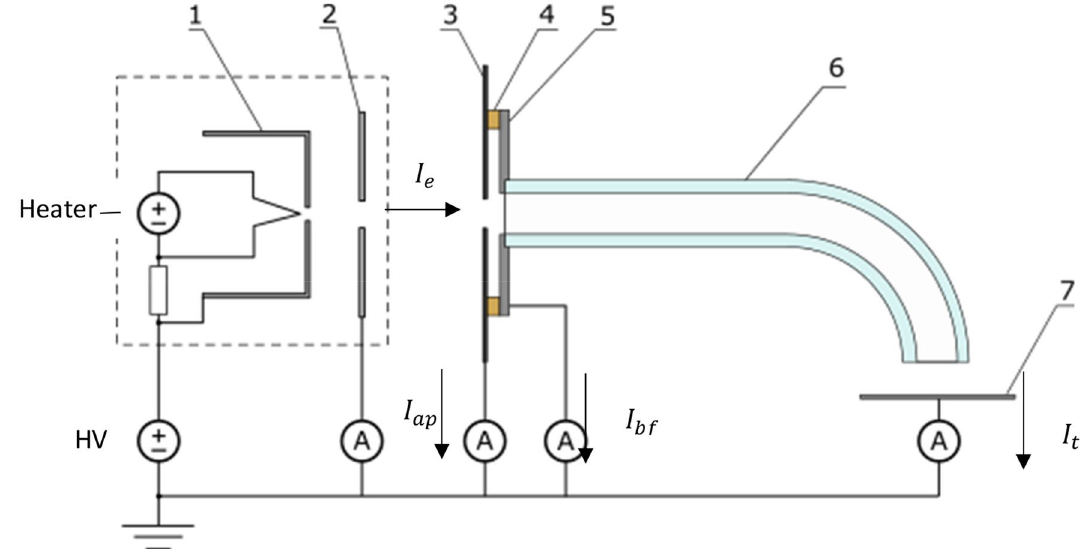
Figure 1. Layout of experiments with electron source (in dashed box) and capillary setup. 1. Wehnelt cylinder, 2. Extractor electrode, 3. Aperture, 4. Insulating spacer, 5. Back-flow electrode, 6. Capillary sample, 7. Target electrode.